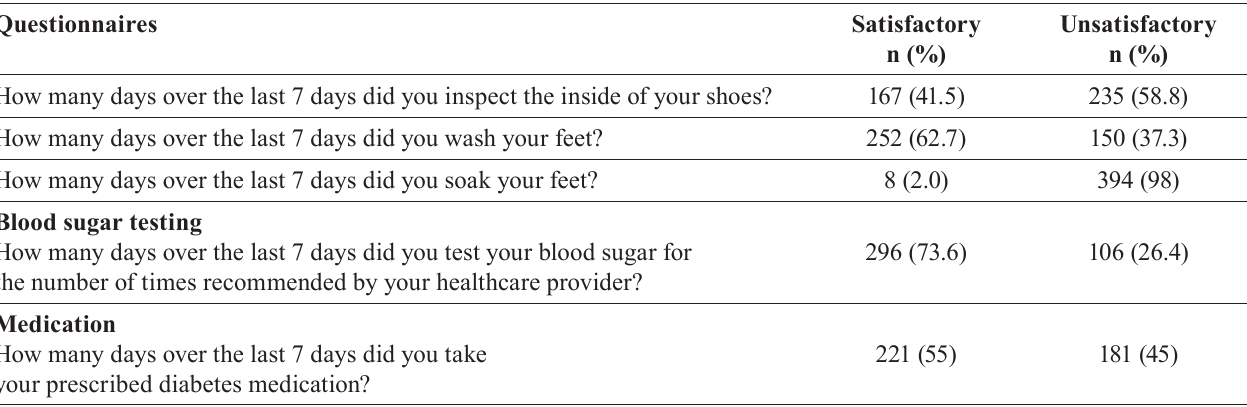
TABLE III - Satisfactory and unsatisfactory responses to self-care practice